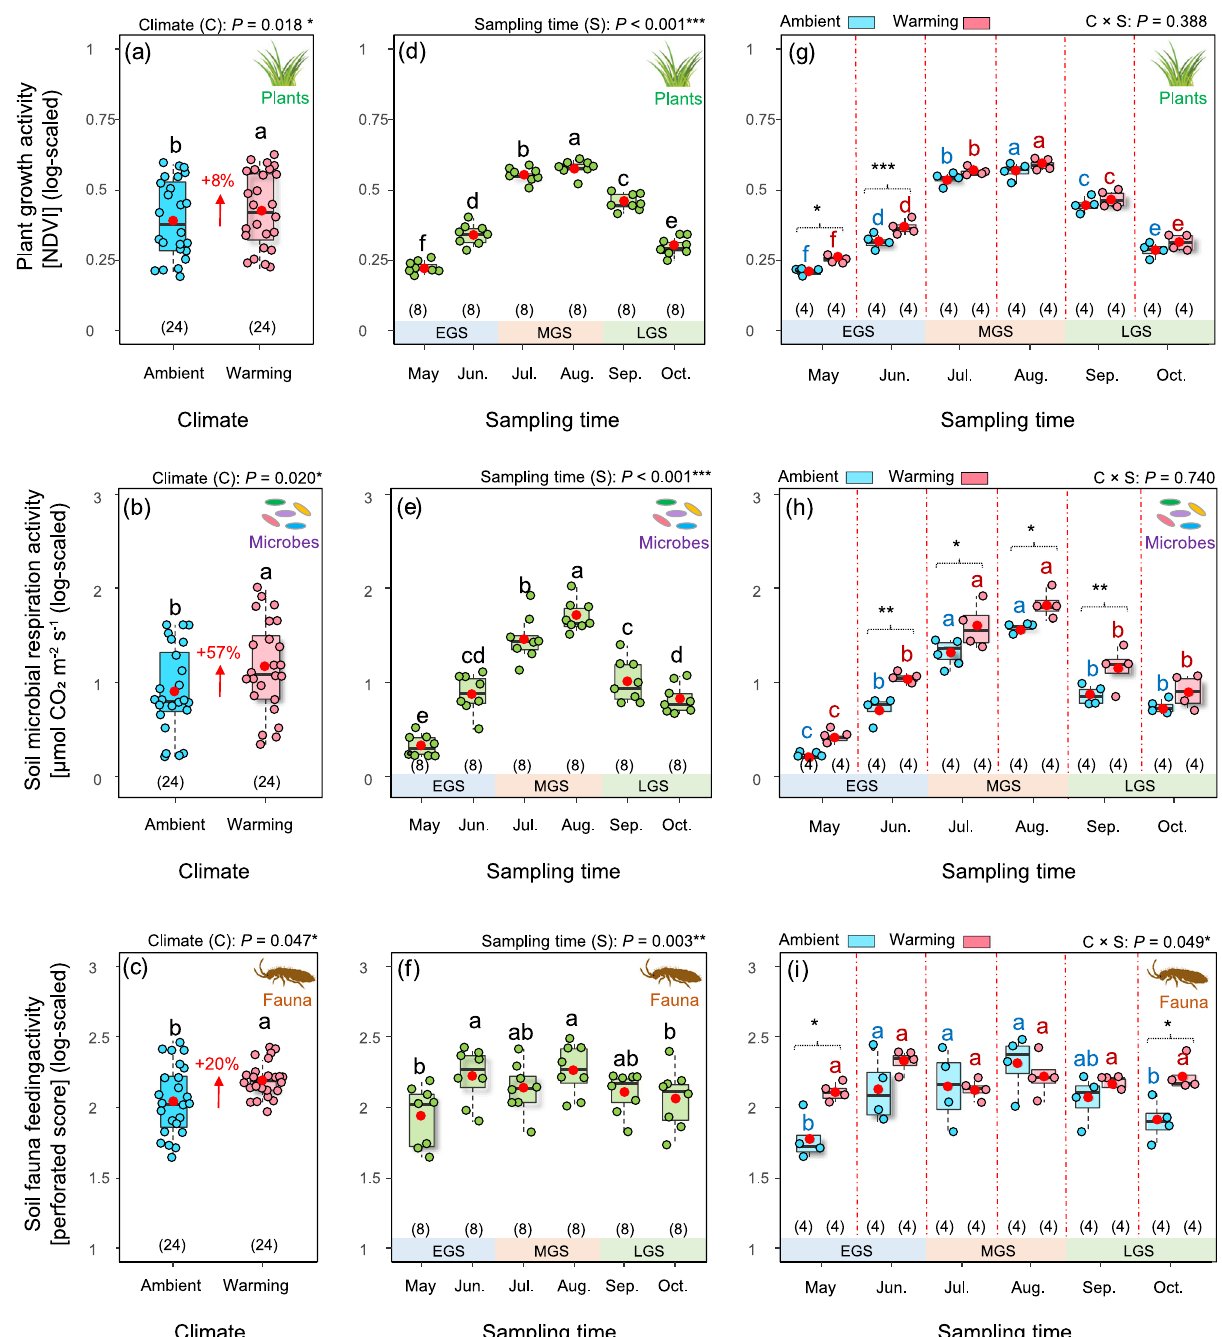
Fig. 2 | Climate and temporal effects on activities of plants, soil microbes, and soil fauna. Effects of climate (ambient vs. experimental warming) on ( a ) plant growth activity ( n =24), ( b ) soil microbial respiration activity ( n =24), and ( c ) soil fauna feeding activity ( n =24). Effects of sampling time (i.e., 6 months of the growing season) on ( d ) plant growth activity ( n =8), ( e ) soil microbial respiration activity ( n =8), and ( f ) soil fauna feeding activity ( n =8). Interactive effects of cli- mate and sampling time on ( g ) plant growth activity ( n =4), ( h ) soil microbial respiration activity ( n =4), and ( i ) soil fauna feeding activity ( n =4). Data were analyzed using linear mixed effects models (see “ Methods ” for details). Based on two-sided tests for multiple comparisons by FDR corrections, different lowercase